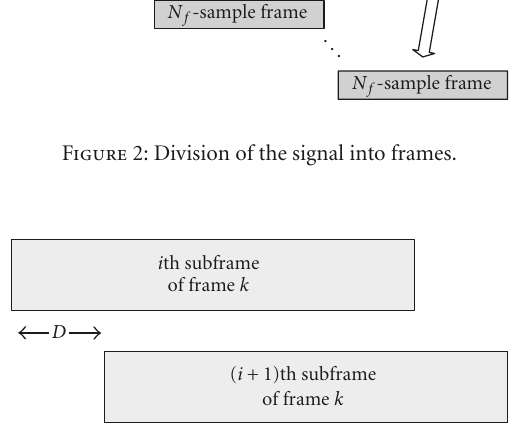
Figure 1: Filter length equalization.